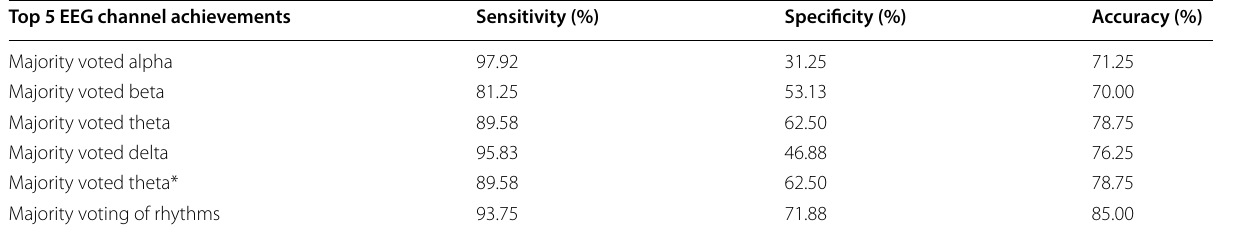
Table 11 The majority voting of the rhythm’s achievements for final emotion recognition (HA vs LA) Top 5 EEG channel achievements